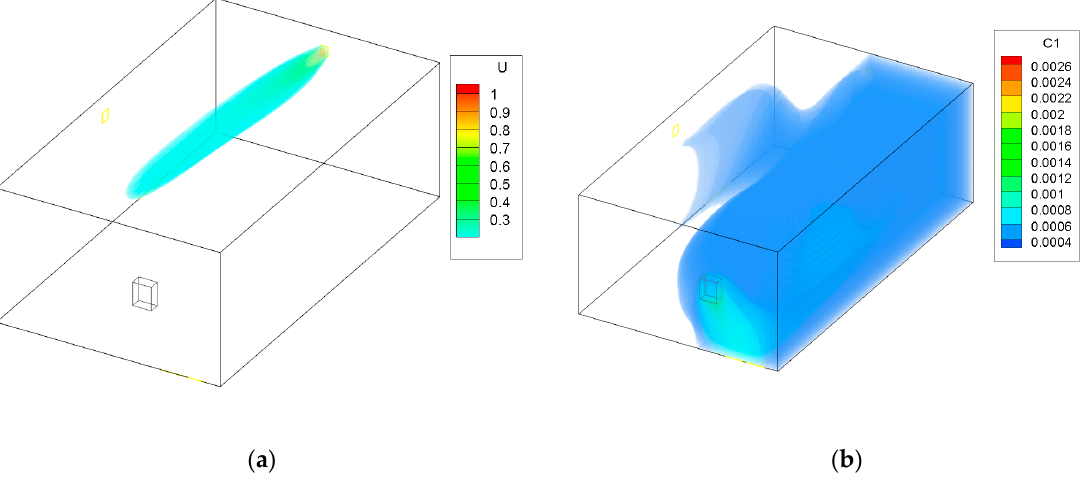
Figure 3. Case 2—minimum flow and maximum area of the ATD; ( a ) air velocity (m/s), ( b ) CO contraction (kg/kg).